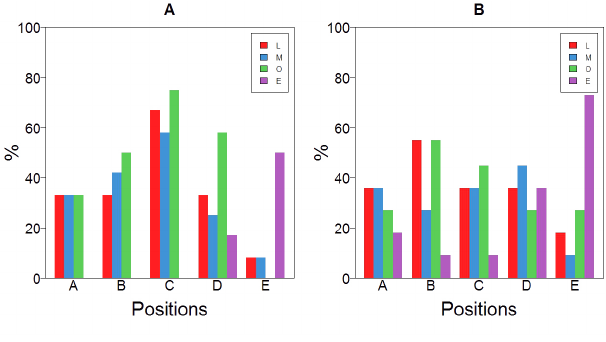
Fig. 7 . Frequency distribution of each role per position in the successful (A) and unsuccessful (B) combinations of social roles. This graphic suggests a pattern in which in successful groups, leaders, and moralists tend to emerge upstream, observers emerge midstream, and enforcers downstream. In unsuccessful groups, enforcers emerge in all positions, probably because of more conflict in the group. L = leader, M = moralist, O = observer, E =